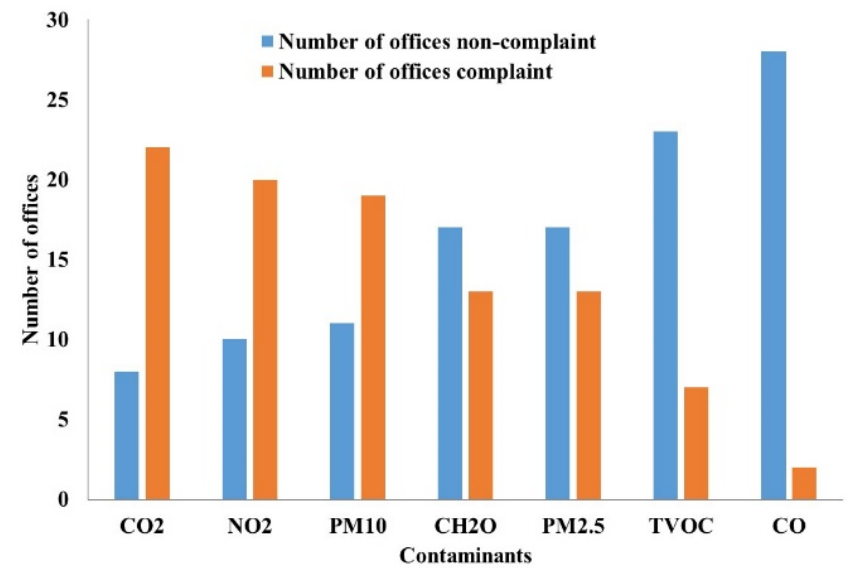
Figure 3. Indoor air quality status in case studies [56].